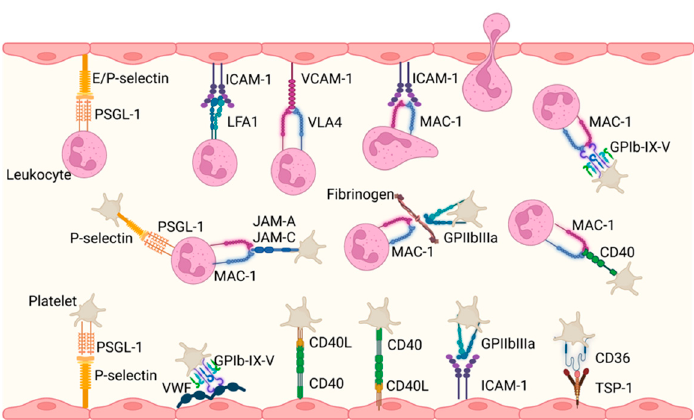
Figure 3. Schematic representation of interactions between platelets, leukocytes (e.g., neutrophils), and endothelial cells in thrombo-inflammation. Platelets interact with both endothelial cells and leukocytes through a variety of receptors/adhesion molecules. Besides activation of platelets, the interactions may induce endothelial cell responses, including apoptosis and inflammation. The interactions between platelets and leukocytes might result in prothrombotic platelet/leukocyte aggregates as well as activation of coagulation through released components of neutrophils. Created with Biorender.com (accessed on 10 October